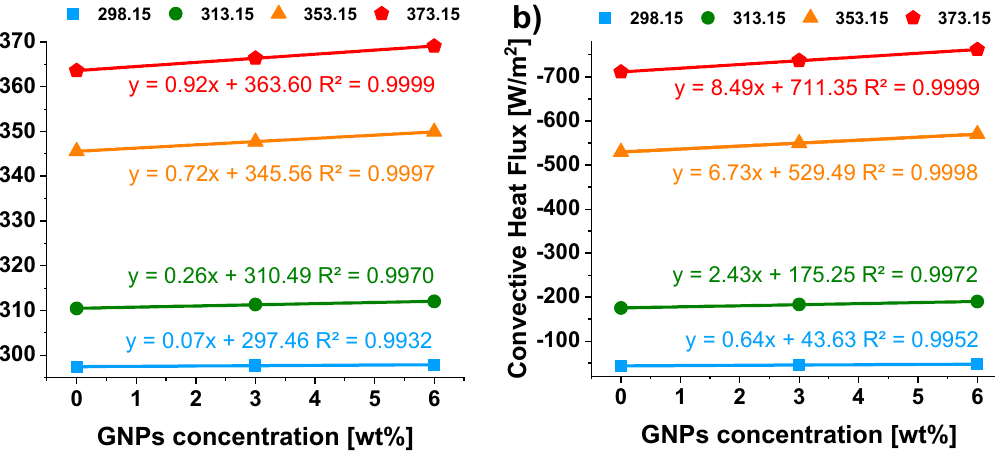
Figure 14. Temperature ( a ) and convective heat flux ( b ) as a function of GNPs concentration at the different temperatures. The lines are the fitting curves of the numerical data (colored markers).